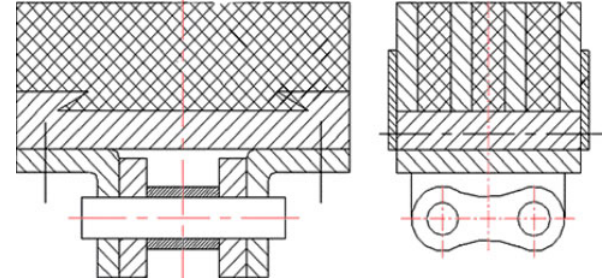
Figure 20 The magnetic unit using type B structure.